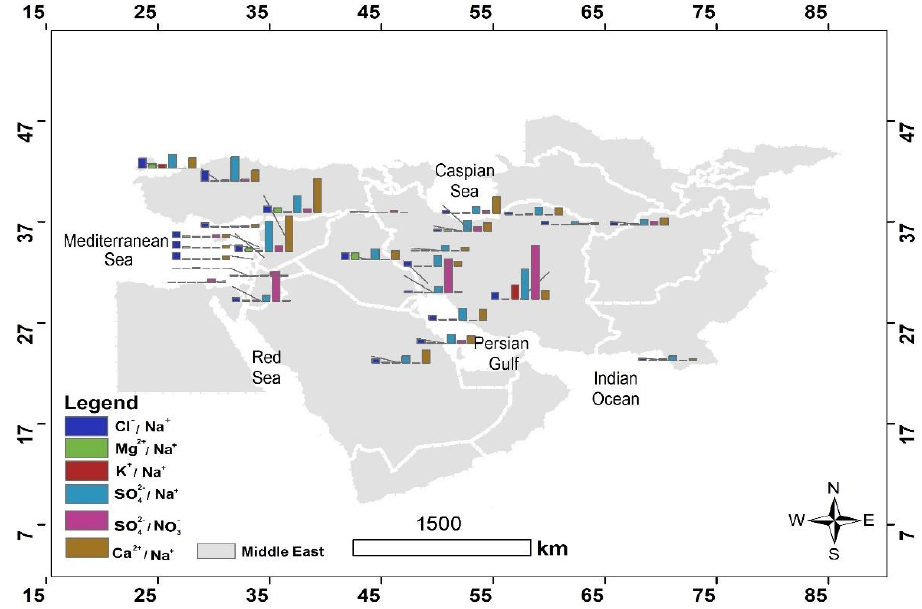
Figure 6. The distribution of major ion ratios in precipitation to Na + and SO4 2- /NO 3- in the studied stations.